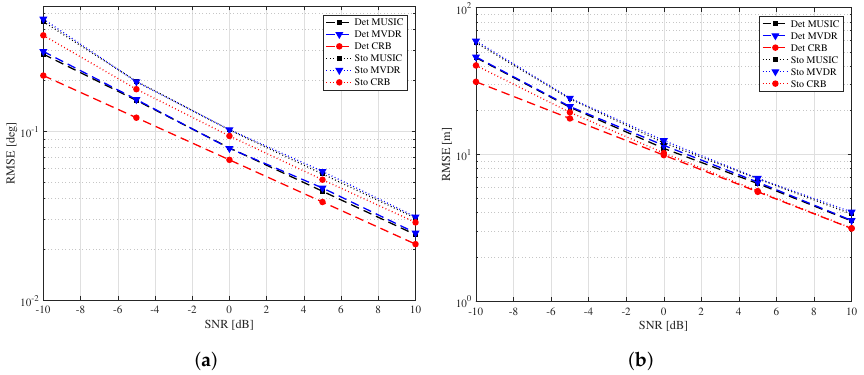
Figure 8. RMSEs of 2-D MUSIC and 2-D MVDR algorithm. The coprime FDA parameters are set as M = 5, N = 3 and ∆ f = 15 kHz. The number of snapshots is set as 100 and the result is obtained through 500 Monte Carlo trials. ( a ) RMSE of DOA estimation. ( b ) RMSE of range